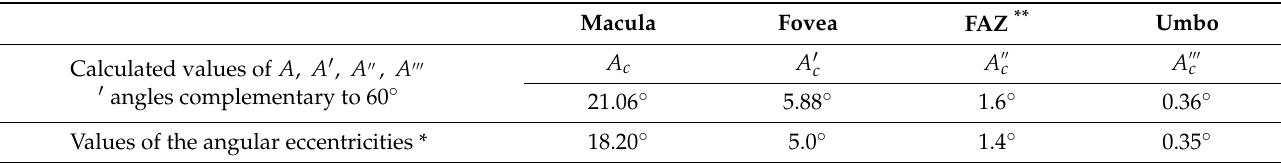
Table 1. Values of calculated complementary angles A c , A (cid:48) c , A (cid:48)(cid:48) c , A (cid:48)(cid:48)(cid:48) c in the hyperbolic geometry Klein–Beltrami (HGKB) model and measured eccentricity angles corresponding to the human retina central region zones. Macula Fovea FAZ ** Umbo A c A (cid:48) c Calculated values of A , A (cid:48) , A (cid:48)(cid:48) , A (cid:48)(cid:48)(cid:48) (cid:48) angles complementary to 60 ◦ Values of the angular eccentricities *